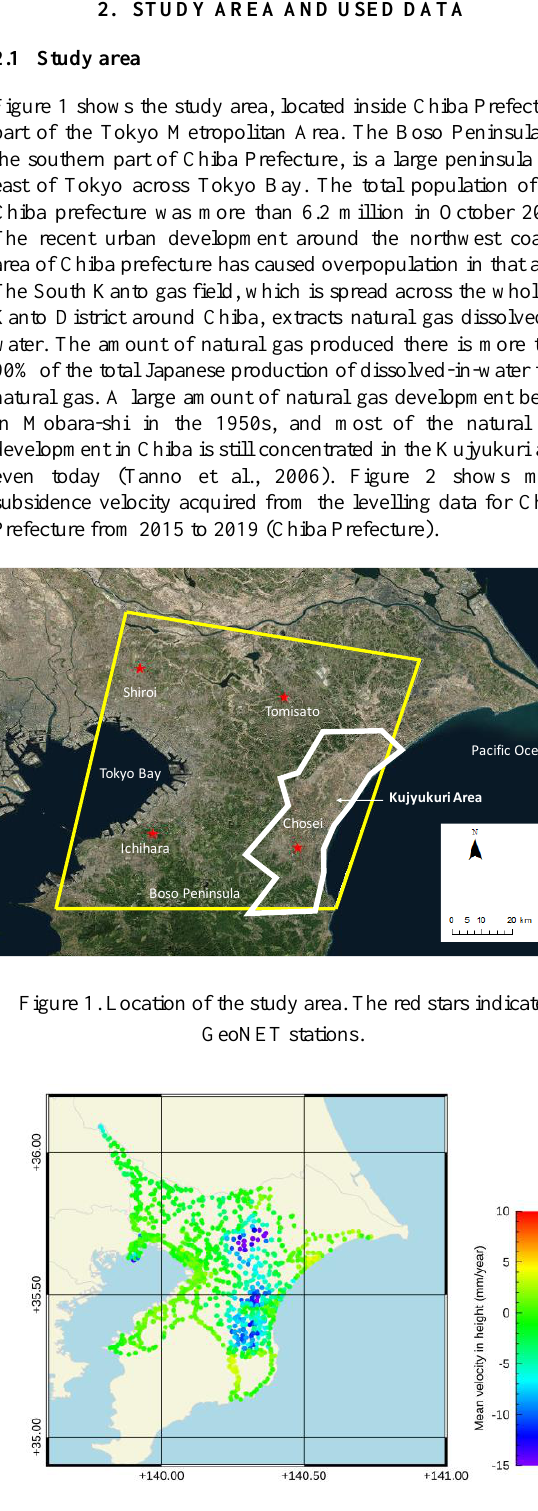
Figure 2. Mean subsidence velocity acquired from the levelling data for Chiba Prefecture from 2015 to 2019